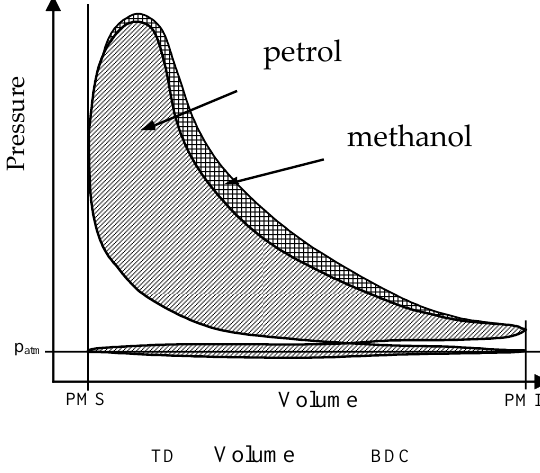
Figure 5. Indicated diagram for petrol and methanol.